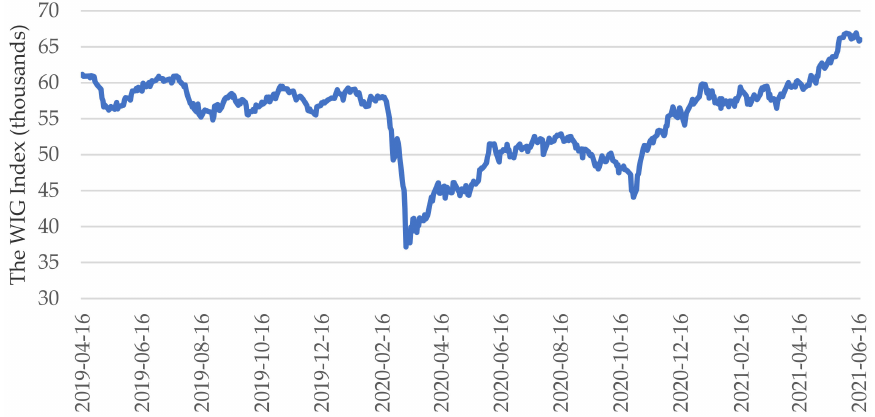
Figure 1. The WIG Index (Warsaw Stock Exchange, Poland) in the period 16 April 2019–18 June 2021. Source: own elaboration on the basis of data from https://stooq.pl [74] (accessed on 19 June 2021). Table 1. Changes of the sectoral WIG indices in Q1 2020 and in Q2–Q4 2020; Warsaw Stock Exchange (Poland). Source: own elaboration on the basis of data from https://www.gpw.pl [73] (accessed on 19 June